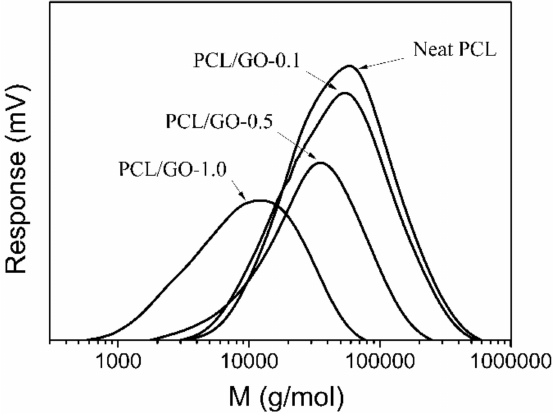
Figure 6. GPC curves of neat PCL and its nanocomposites after leaving 50 days.